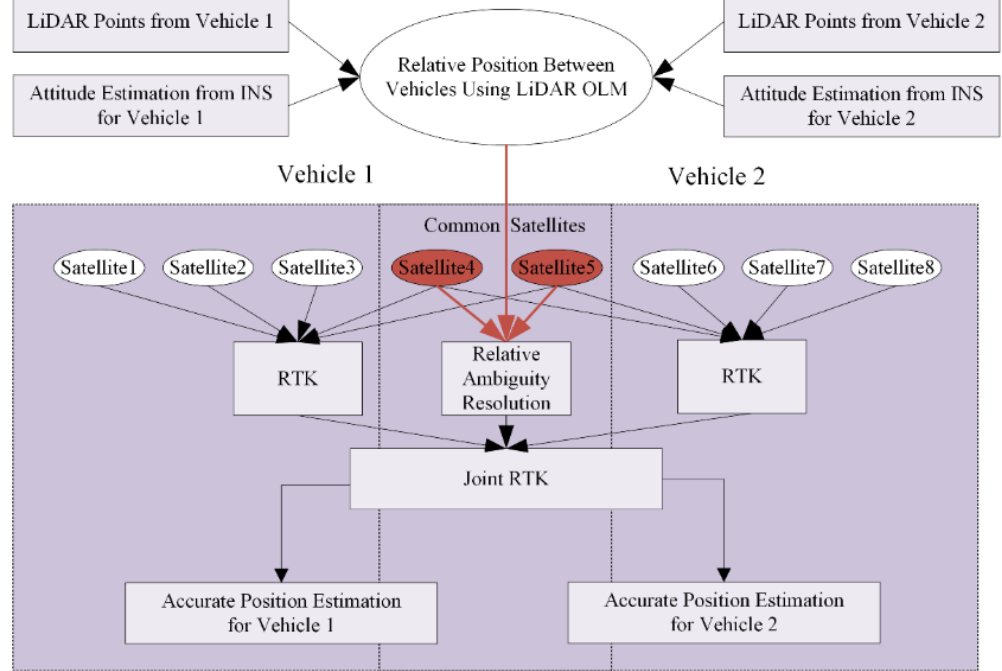
Figure 2. Flowchart of our methods, and satellites with a red background are common satellites of vehicle 1 and vehicle 2. Table 1. Pseudocode of the main procedures in our methods.